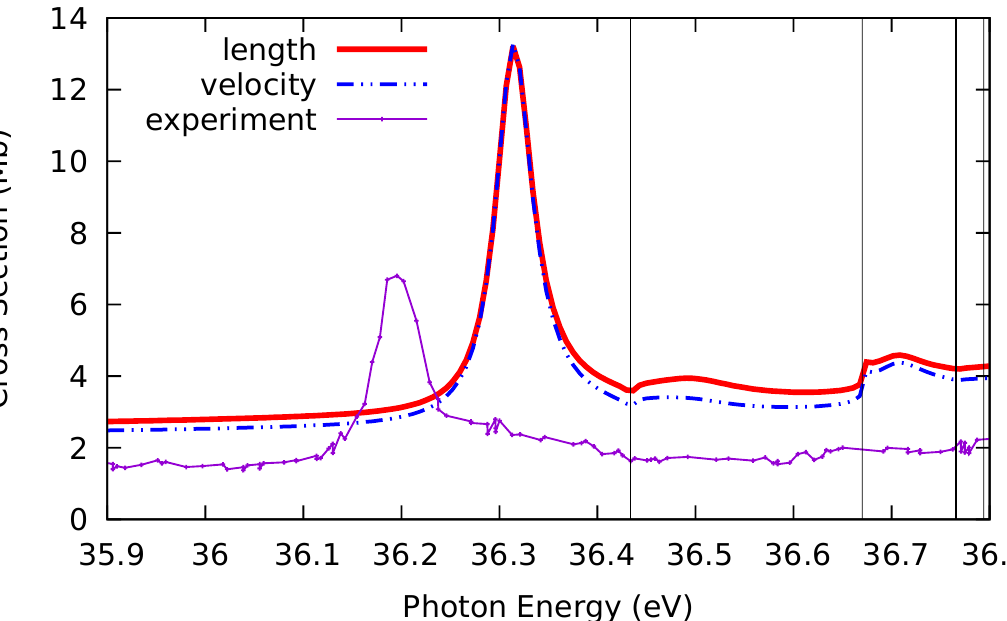
Figure 3. Photodetachment of Na − near the Feshbach resonance just above 36 eV. The calculated inner-shell thresholds are shown as vertical black lines.